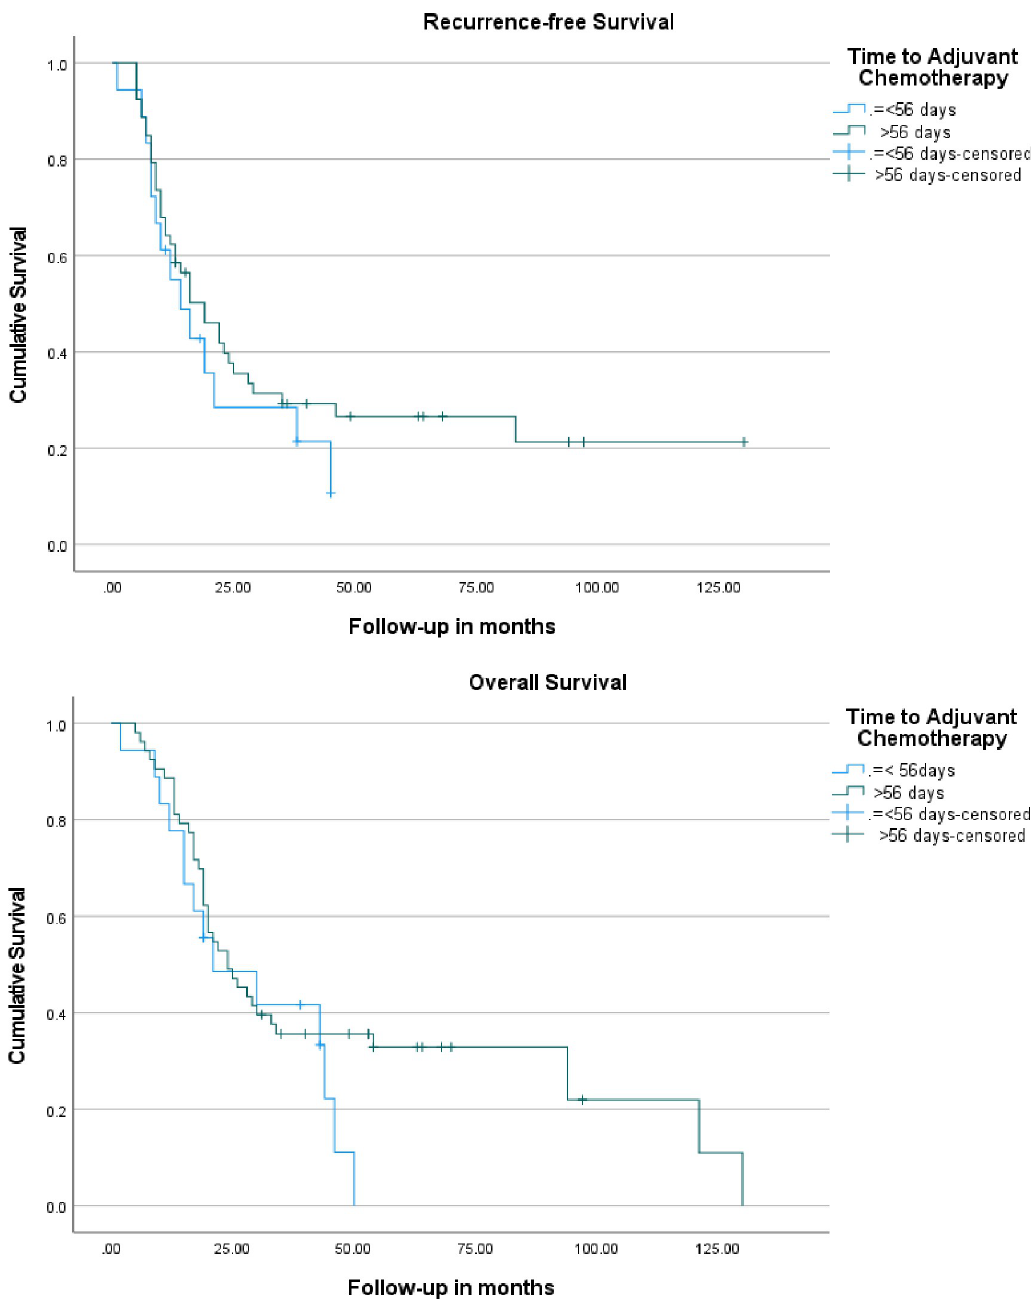
Fig 2. A. Kaplan-Meier recurrence-free survival curves of the patients who received adjuvant chemotherapy within 56 days of surgery to those who received adjuvant therapy beyond 56 days. B. Kaplan-Meier overall survival curves of the patients who received adjuvant chemotherapy within 56 days of surgery to those who received adjuvant therapy beyond 56